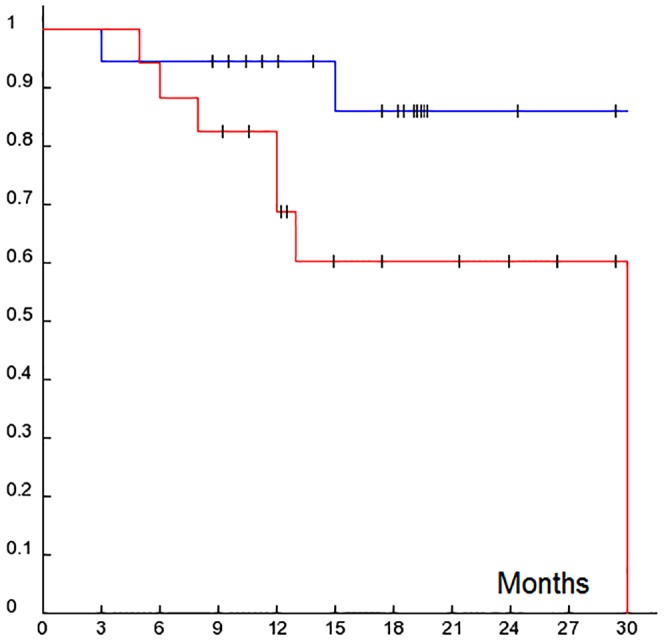
Kaplan–Meier estimate of survival function.Kaplan–Meier estimate of survival function of metastatic breast cancer patients separated on CTC-positive (red line) and CTC-negative (blue line) groups. The survival period in month of the corresponding patient. Censored patients are indicated by vertical bars (|). Statistical significance determined by log-rank test. Shorter survival correlates with presence of CTCs in blood (P: 0.0332, HR: 7.38, (CI = 0.84-64.09)).